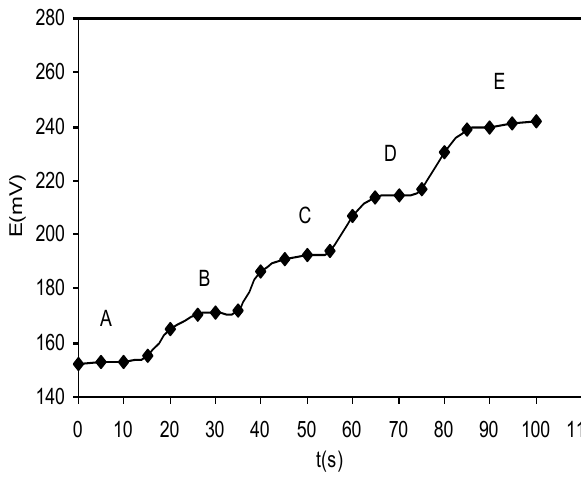
Figure 4. Dynamic response time of the neodymium electrode for step changes in the Nd 3+ concentration: A) 1.0 × 10 -6